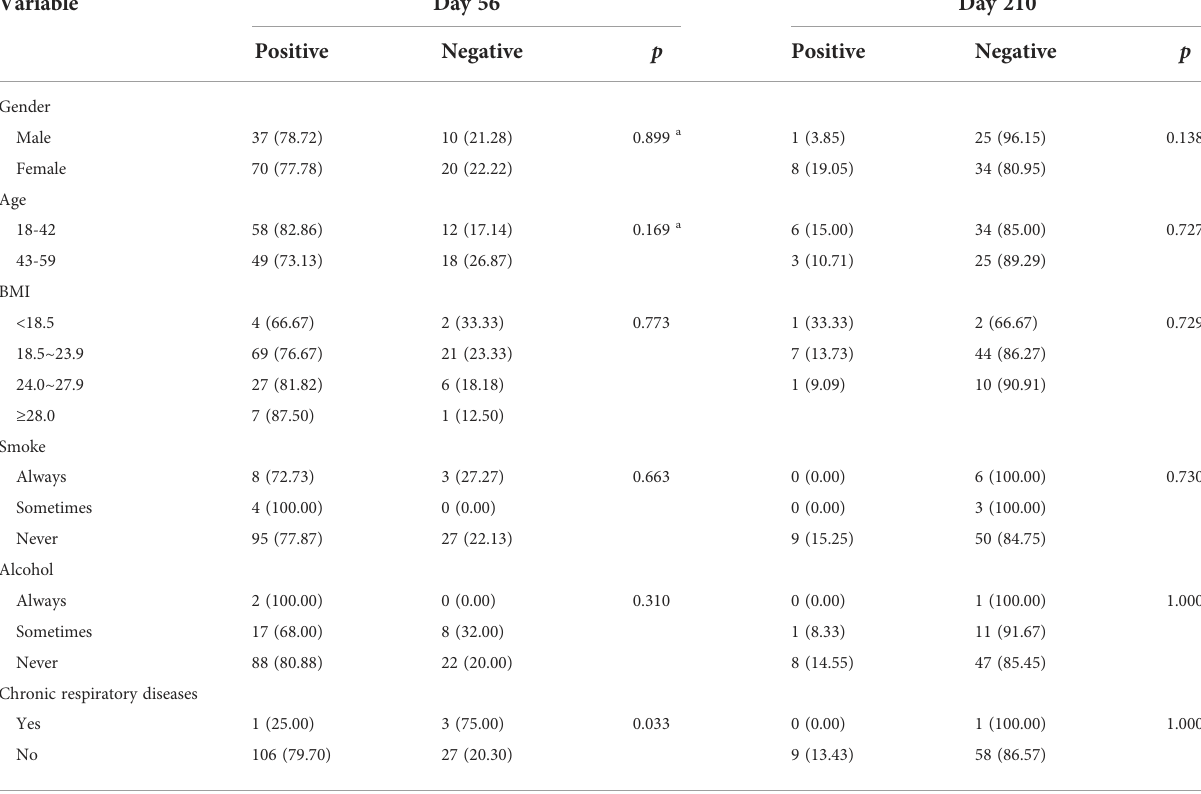
TABLE 3 Associations between participants ’ characteristics and neutralizing antibodies to live SARS-CoV-2. Variable Day 56 Day